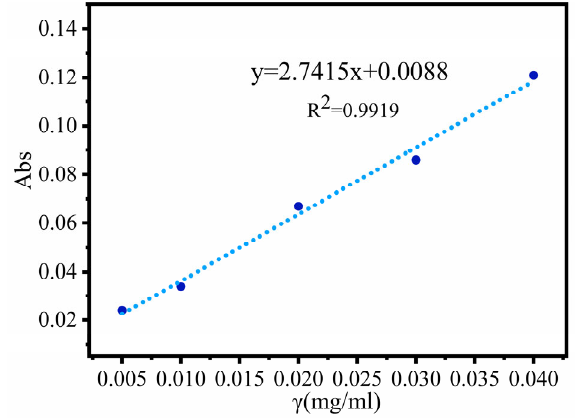
Figure 4. UV standard curve for SPEO.